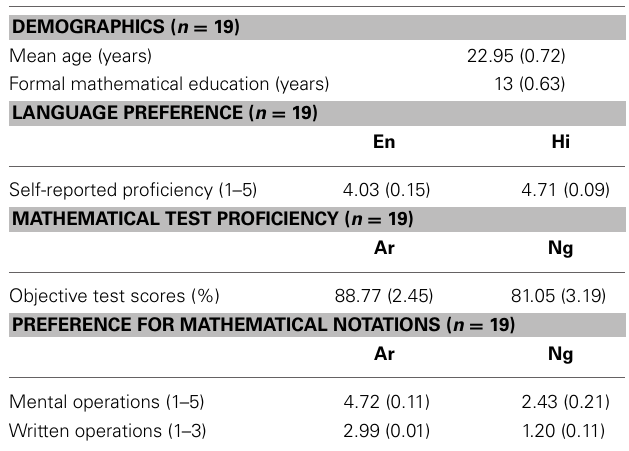
Table 1 | Demographics, preference and performance of the participants as measured by a language and mathematics